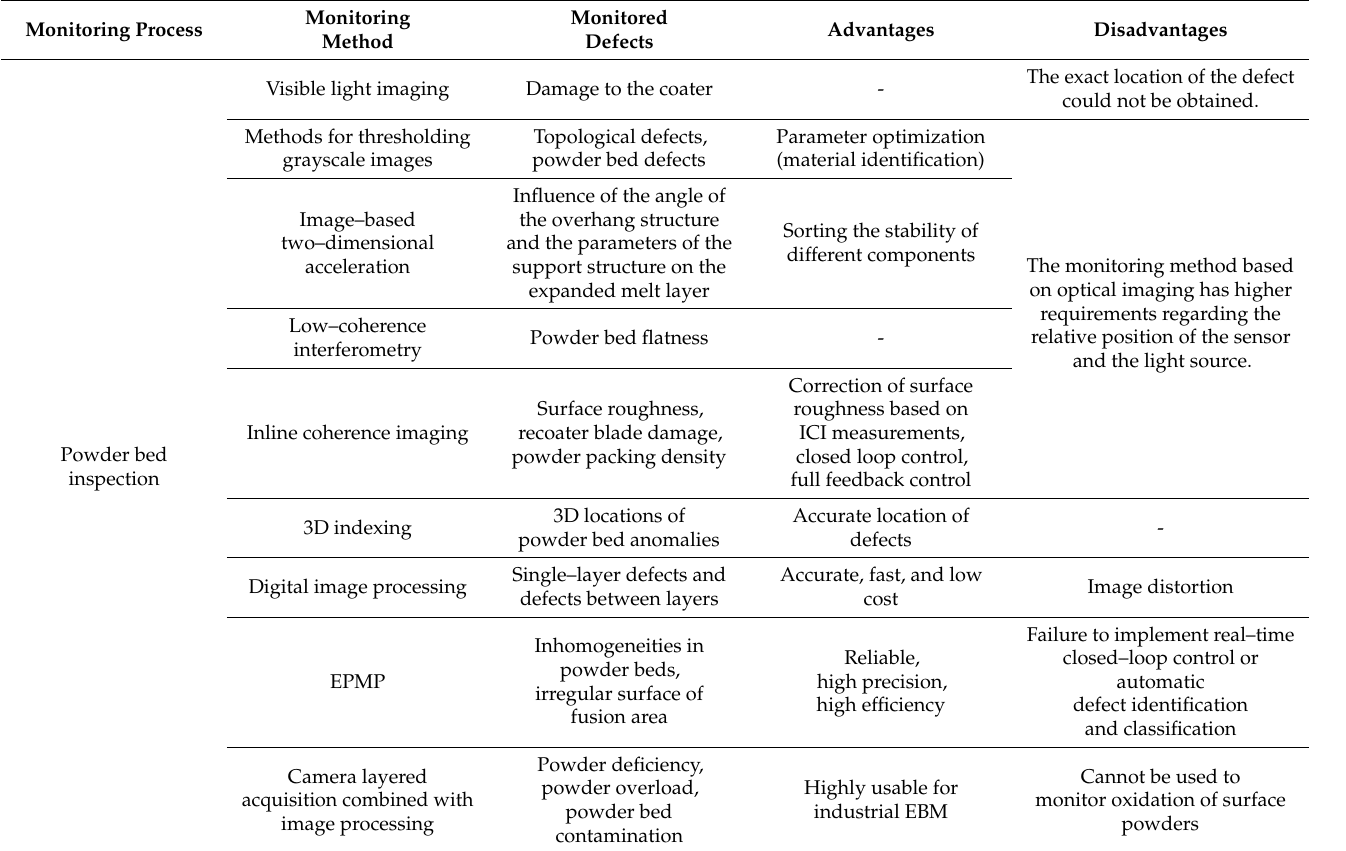
Table 2. An overview of powder bed